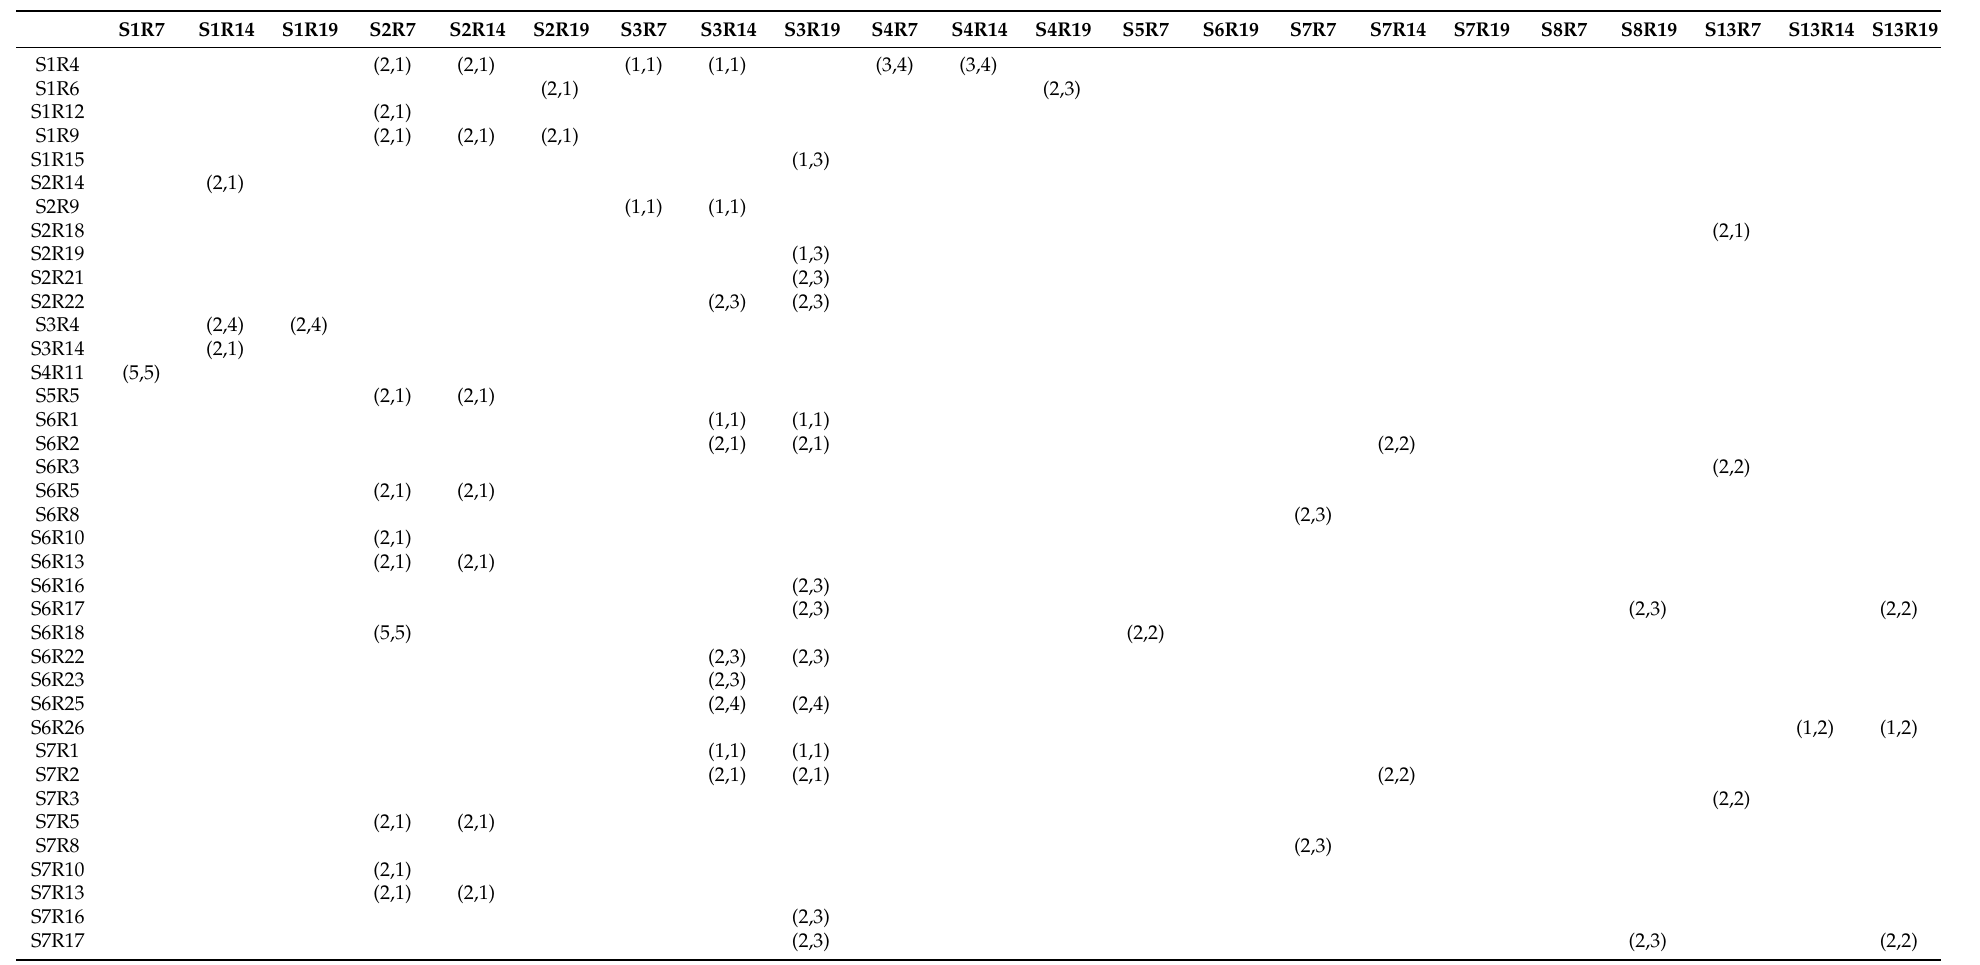
Table A1. Matrix associated with SNA. Within each cell of the matrix are the values associated with risks: the left represents the impact, while the digit located on the right side represents